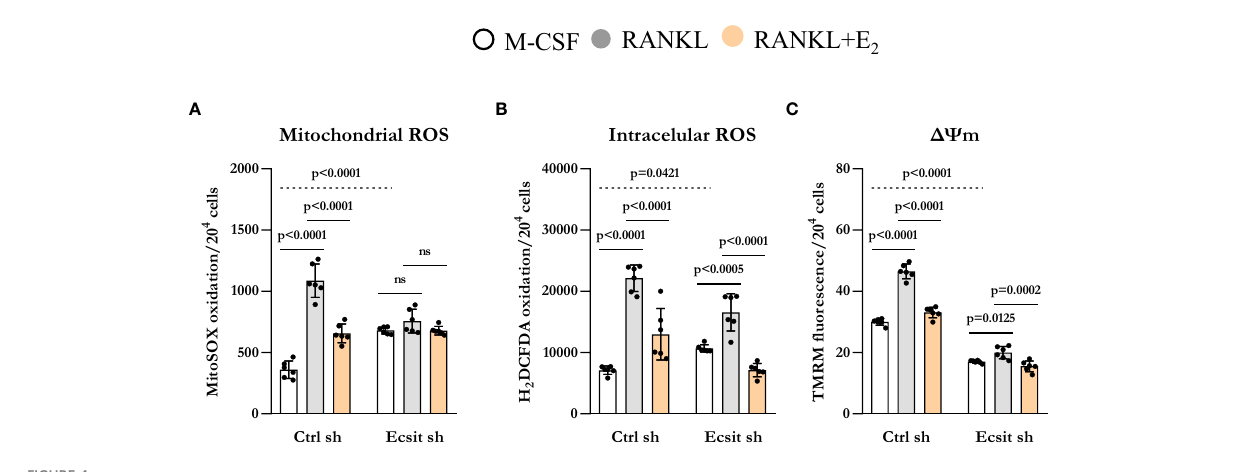
FIGURE 4 Knockdown of ECSIT induces mitochondrial dysfunction. BMMs silenced with control or Ecsit sh (#2) and cultured with M-CSF, RANKL and E 2 for 24 hours, stained with (A) MitoSOX and (B) H 2 DCFDA and (C) TMRM to evaluate mitochondrial ROS, intracellular ROS, and mitochondrial membrane potential, respectively. Bar graphs depict mean ± S.D. of 6 wells (black dots) of one representative experiment; p values analyzed by 2-way ANOVA. ns=not signi fi cant